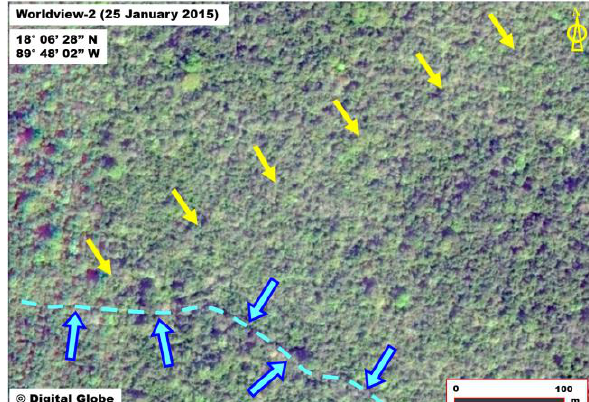
Figure 11. Comparison between an access road (blue arrows) and the nearby sacbe segment #3 (yellow arrows) of Folan et al. (1995), located in a forested area on a WorldView-2 true-colour composite acquired in January 2015 and displayed on Google Earth. The location of the sacbe is indicated by yellow arrows.